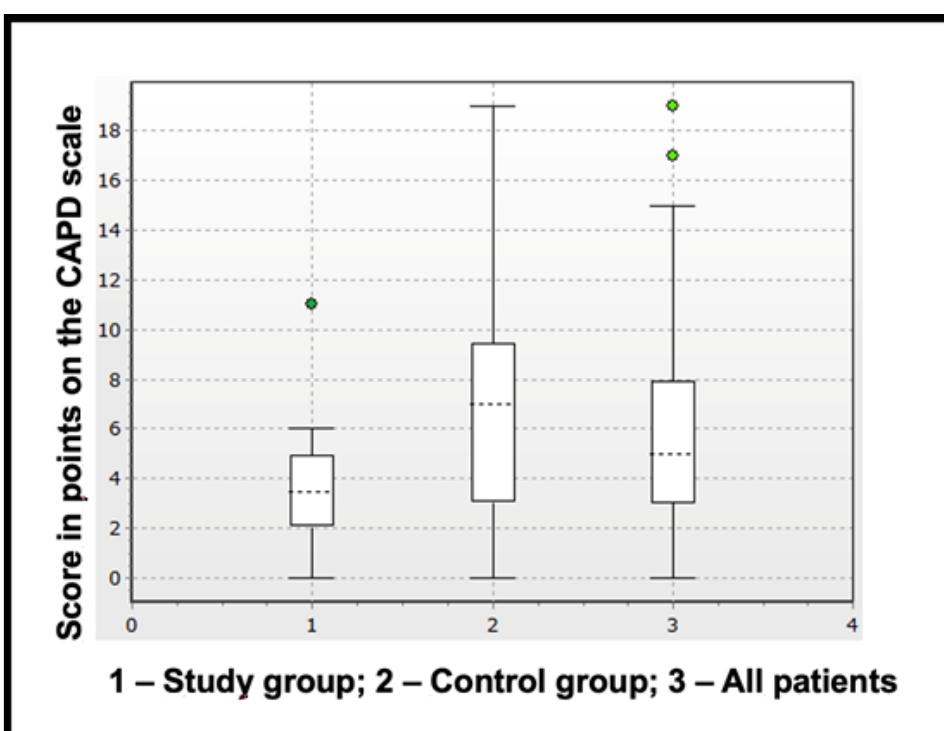
Figure 1. Score in points on the CAPD scale.